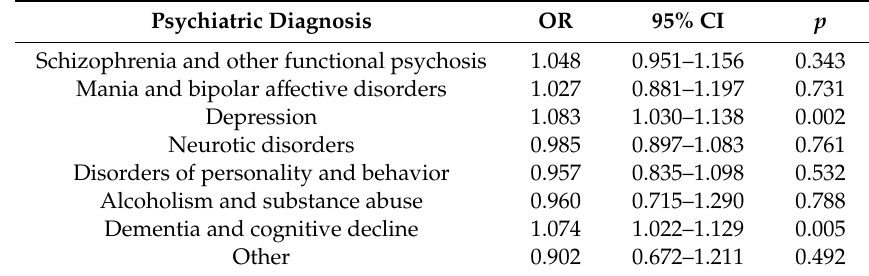
Table 4. Odds Ratio (OR) of dying per 1 ◦ C increase above 24 ◦ C in Mean Apparent Temperature (lag 0–1) and 95% confidence interval (CI) by psychiatric